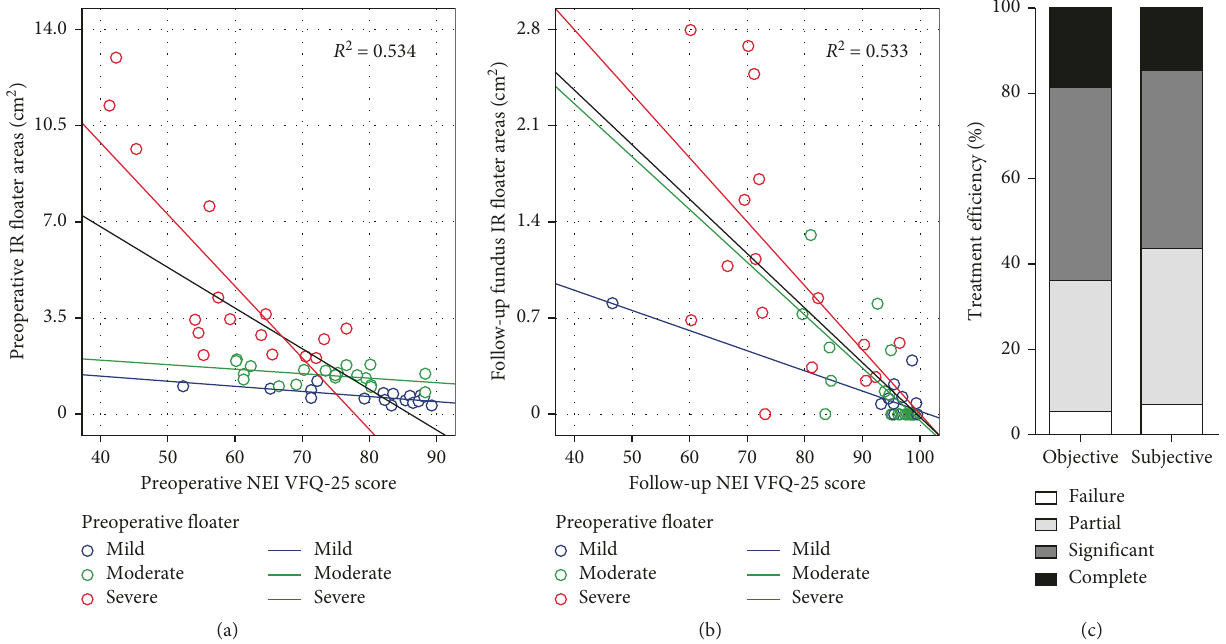
Figure 3: Association between objective and subjective clinical efficacy of YAG laser treatment. Scatter plot of NEI VFQ-25 questionnaire scores and floater shadow areas before YAG laser treatment (a) and at follow-up (b). (c) Comparison between objective and subjective clinical efficacy of YAG laser